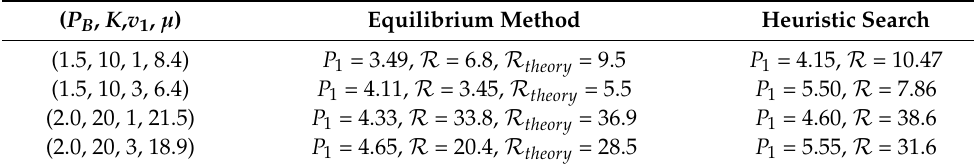
Table 7. Small capacity networks with infrequent arrival rate broadcast ( F =